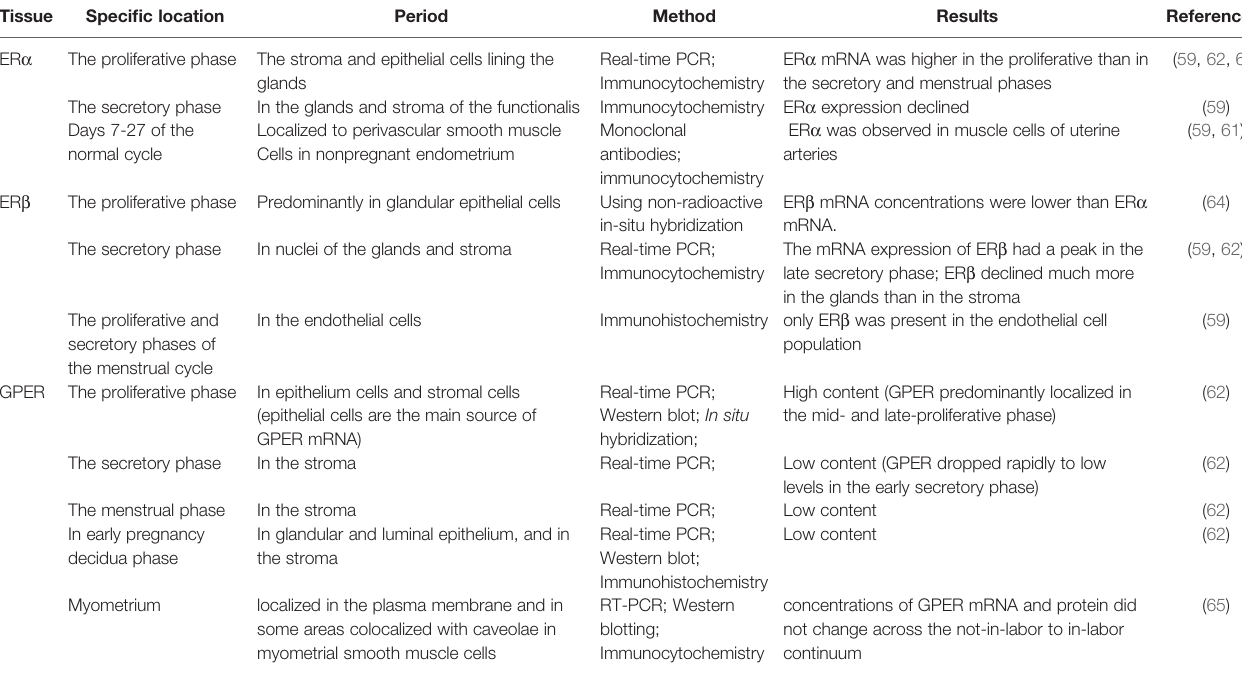
TABLE 1 | ER expression by uterine